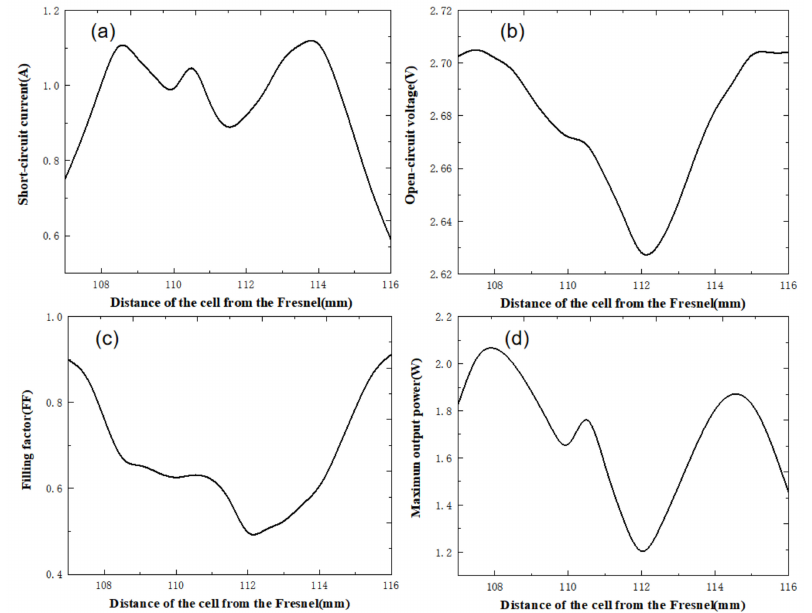
Figure 7. Variation in cell characteristic parameters in the direction of optical axis: ( a ) short-circuit current; ( b ) open-circuit voltage; ( c ) filling factor; ( d ) maximum output power.